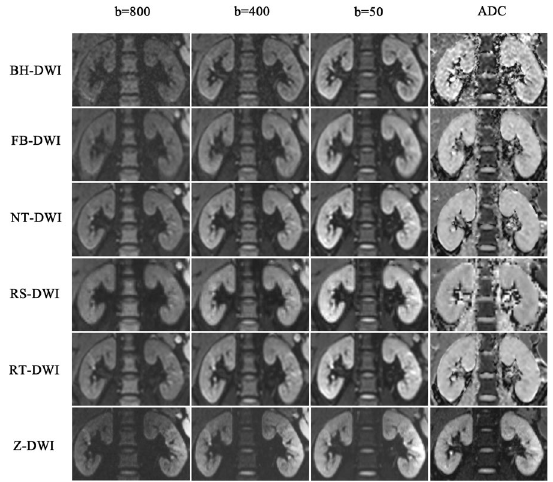
Figure 3. Comparisons of image quality of BH-DWI, FB-DWI, NT-DWI, RT-DWI, RS-DWI and Z-DWI. Diffusion-weighted trace images at three different b-values (800, 400, 50 s/mm 2 ) with the corresponding ADC maps (right) are arrayed. Z-DWI had a better image quality than BH-DWI and FB-DWI in clarity of the renal cortex and medulla (K4) (ADC map) (all P < 0.05) and RS-DWI in sharpness of boundaries (K1), clarity of the renal cortex and medulla (K4) and overall image quality(K5) (all P < 0.05). Z- DWI was slightly superior to RT- DWI and NT-DWI in sharpness of boundaries (K1, ADC map); however, the difference in image quality between the three was not significant (all P > 0.05).